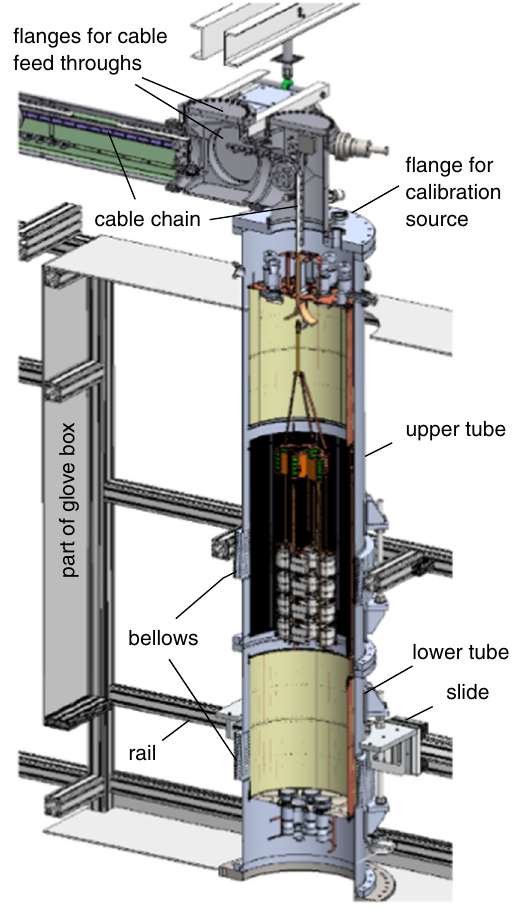
Fig. 19 VerticalpartofthePhaseIIlockwiththeGedetectorarrayand the LAr veto system in retracted position. Both upper and lower tube are enclosed by a glove box. The lower tube can be laterally moved such that the resulting gap allows the installation and service of both the Ge detector array and the LAr veto system